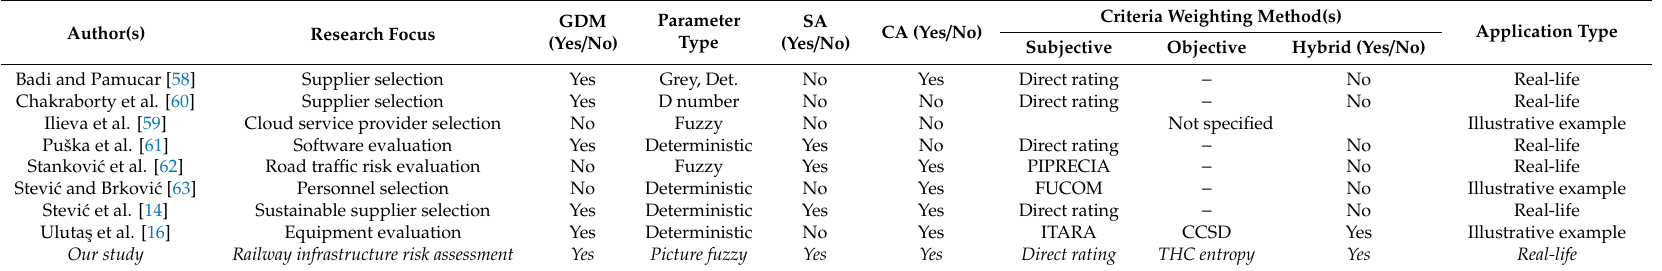
Table 2. Summary of the available applications and extensions of the MARCOS